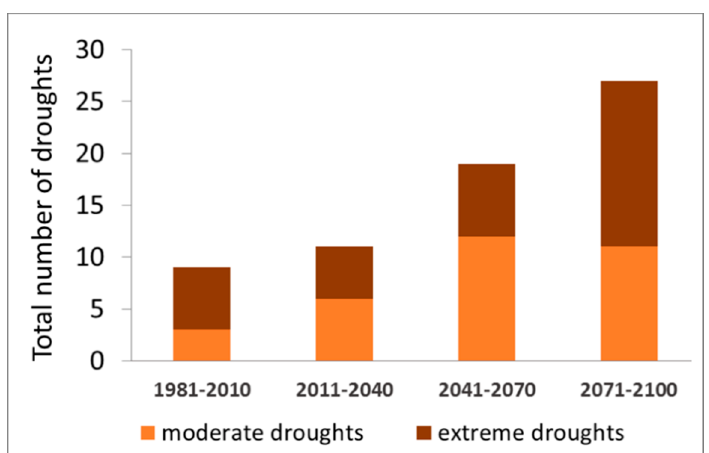
Figure 1. Total number of moderate and extreme summer drought years (May to August) for 30-year periods in Southwest Hungary. 1981–2010: Observed data; future periods: Observed data adjusted with changes based on the mean of projections of 12 regional climate simulations, assuming the A1B emission scenario (adapted from Gálos et al. [38]). Drought definition is based on [39]. (See also Figure 5).